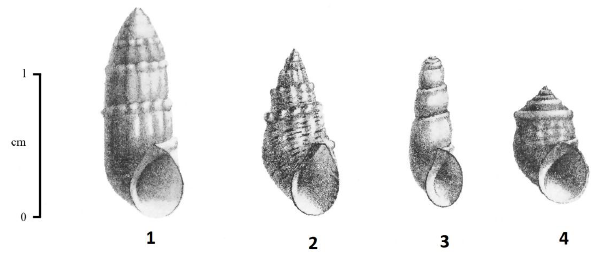
Fig. 1. Example of taxonomic hyper-splitting in modern Lake Malawi molluscs. Representatives of the four thiarid genera created by Bourguignat (1889), endemic to Lake Malawi: 1 - Nyassia mag- nifica; 2 - Nyassella pulchra; 3 - Nyassomelania truncatelliformis and 4 - Micronyassia singularis . All ca. 40 thiarid species recog- Fig. 1. nized by Bourguignat have been shown by molecular research to be parthenogenetic clones belonging to the “ Melanoides polymorpha- complex”. Some (e.g., Melanoides truncatelliformis ) are still “offi- cially” considered as distinct endemic species (Scale bar: